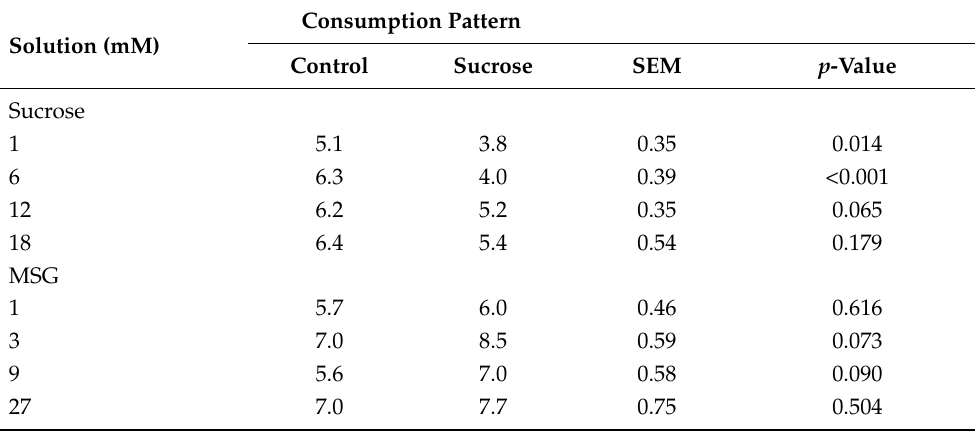
Table 3. Consumption patterns of pigs from control and sucrose groups for sucrose and MSG 1